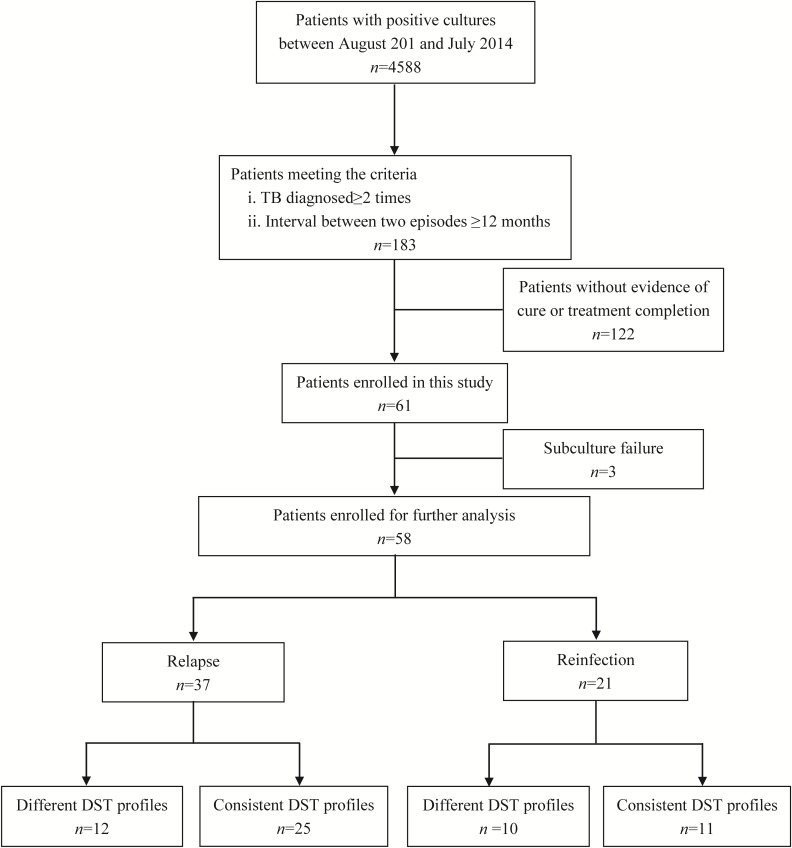
Patients Enrollment.